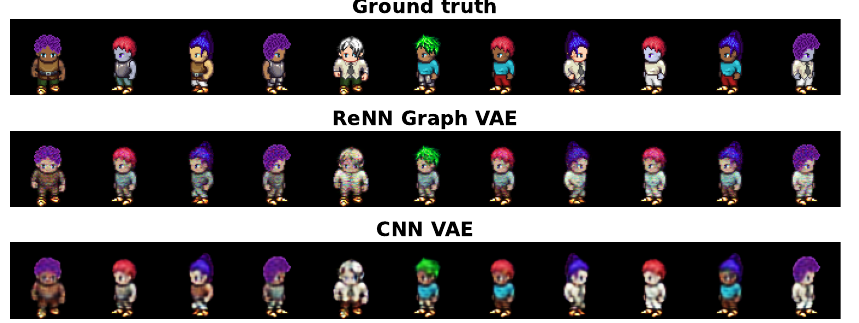
Figure A1. Ground truth vs. reconstructed sprites . Comparison between sprites from the test set with their reconstructed counterpart by ReNN Graph VAE and a standard CNN